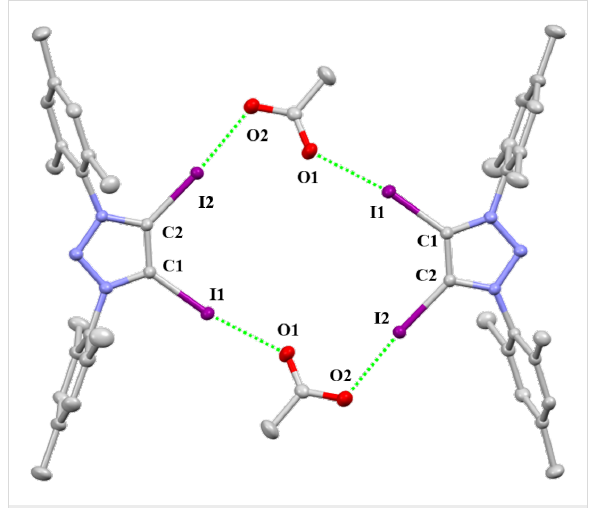
Figure 4: Packing structure of 2-OAc . Hydrogen atoms and solvent molecules have been omitted for clarity. The single crystal of 2-TFA crystallizes in the monoclinic space group P 2 1 / n , but the packing structure of 2-TFA is different